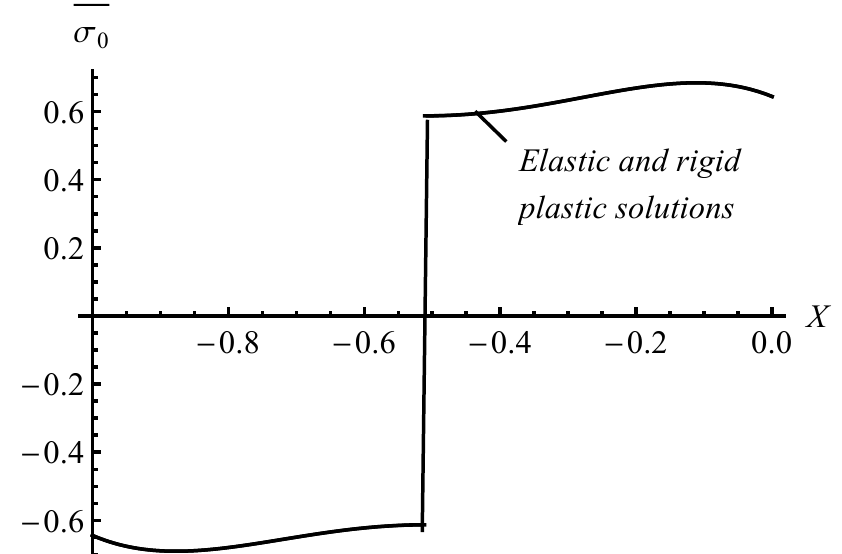
Figure 5. Distribution of the stress σ θ at H / r CD = 0.04 found using the elastic/plastic and rigid/plastic